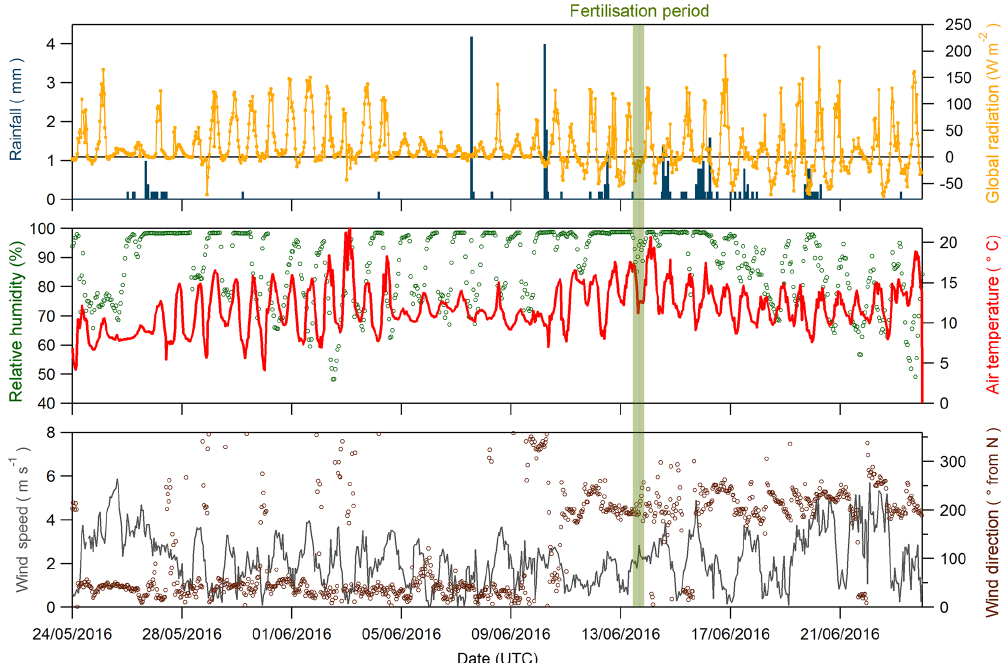
Figure 2. Global radiation (orange line), rainfall (blue bars), relative humidity (green dots), air temperature (red line), wind direction (brown circles) and wind speed (grey line) recorded during the Easter Bush campaign, May to June 2016. The fertilisation period was 08:00–09:00 on 13 June and is highlighted in